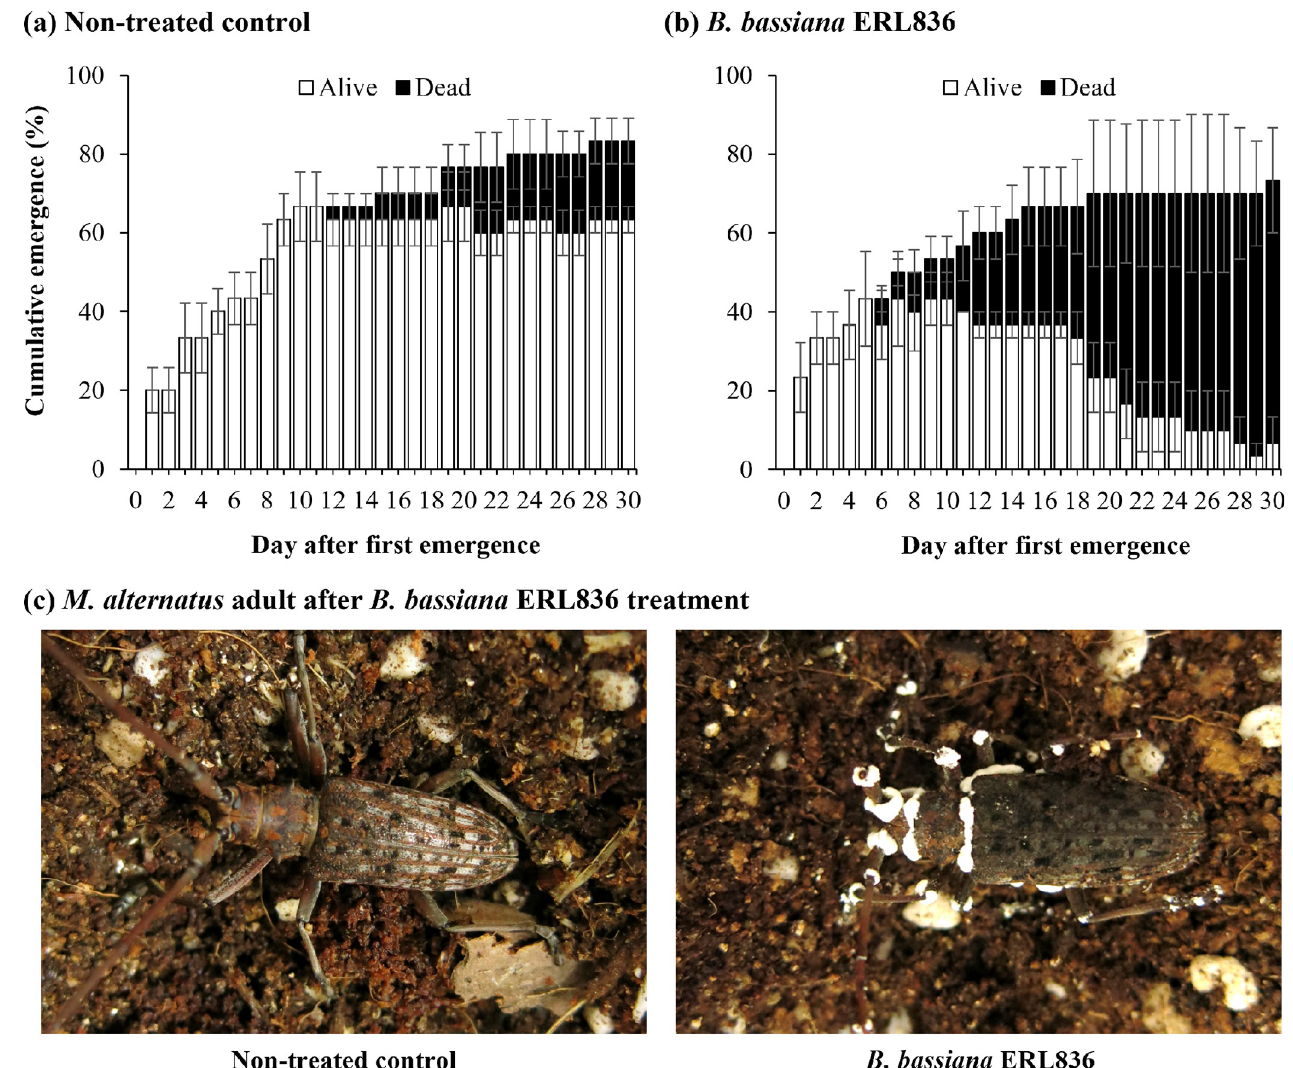
Fig 2. Insecticidal activity of B . bassiana ERL836 against M . alternatus adults using fungal pre–treatment of pine logs artificially infested with larvae. The 100–ml fungal conidia suspension (1.0 × 10 7 conidia/ml) was sprayed onto pine logs artificially infested with 5th instar larvae of M . alternatus , and then the logs were placed in a plastic box, and the lid was closed and sealed. Cumulative emergence of M . alternatus adults in the non–treated control (a) or ERL836 treatment (b) was counted daily after the first observation of emergence. In the emergence, the percentages of alive and dead numbers were presented as white and black, respectively. A mycotized adult was observed in the ERL836 treatment